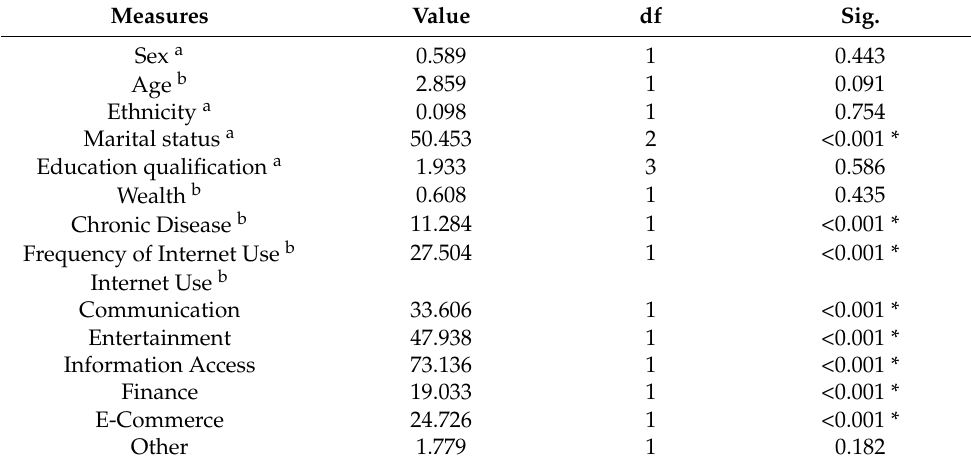
Table 3. Bivariate analysis of the association between the quality of life of older people and the independent variables ( n = 5272). Measures Value df